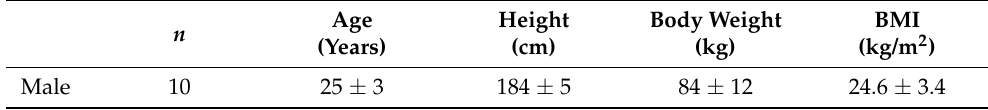
Table 3. Demographic data.